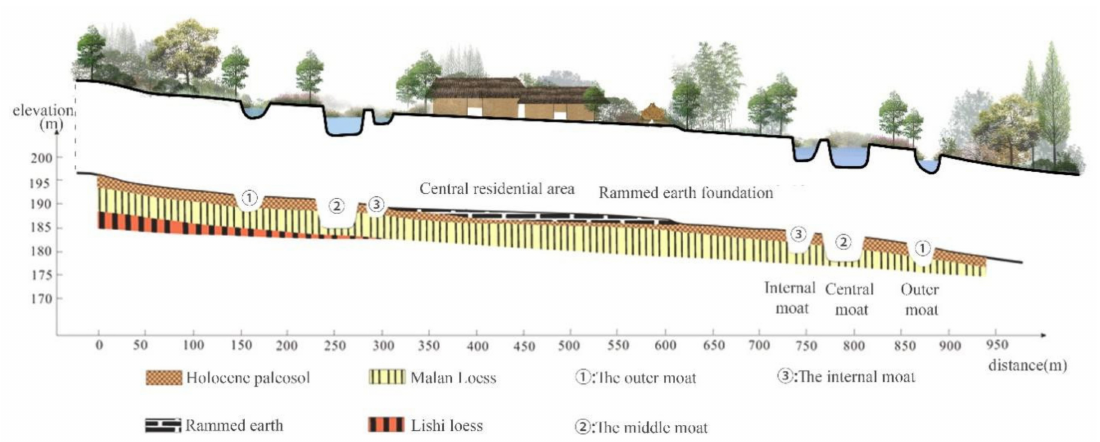
Figure 18. Profile reconstruction landscape of the SHS site.